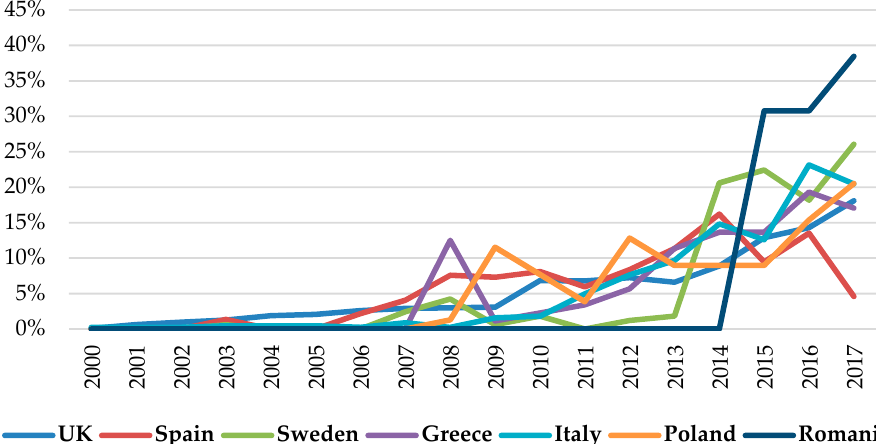
Figure 1. Percentage of annual increase of new products with animal welfare claims in several European Union (EU) countries (own elaboration, from Global New Product Database (GNPD)).